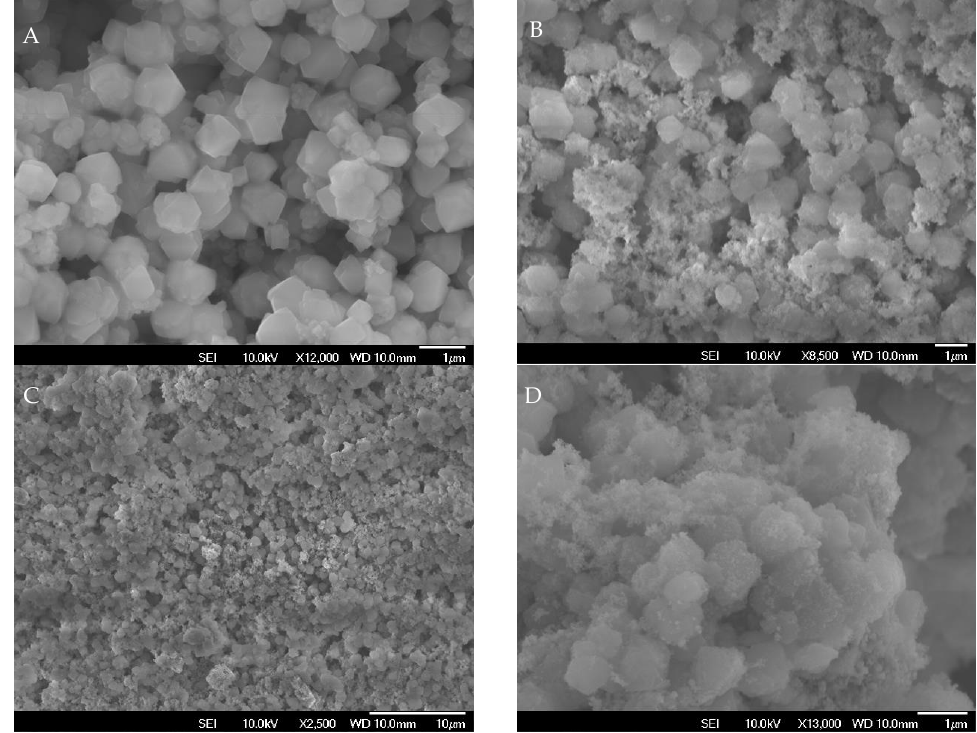
Figure 6. Representative SEM micrographs of ( A ) synthesized NaX zeolite, ( B ) fresh Co/NaX, ( C ) fresh Co/NaX at a larger scale, ( D ) recycled Co/NaX.